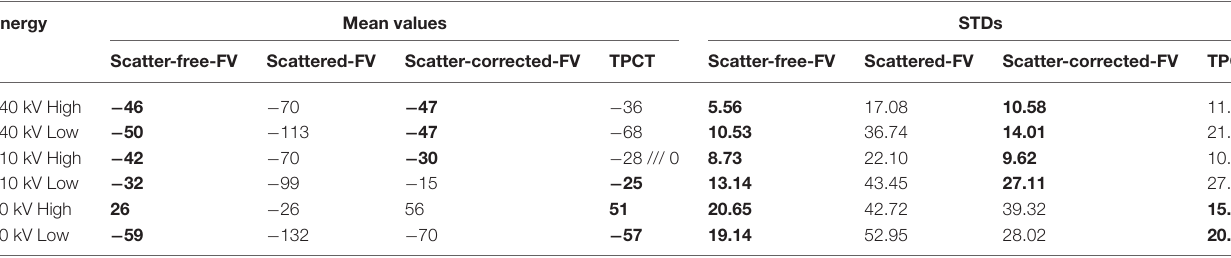
TABLE 3 | The mean values and STDs of the ROI.